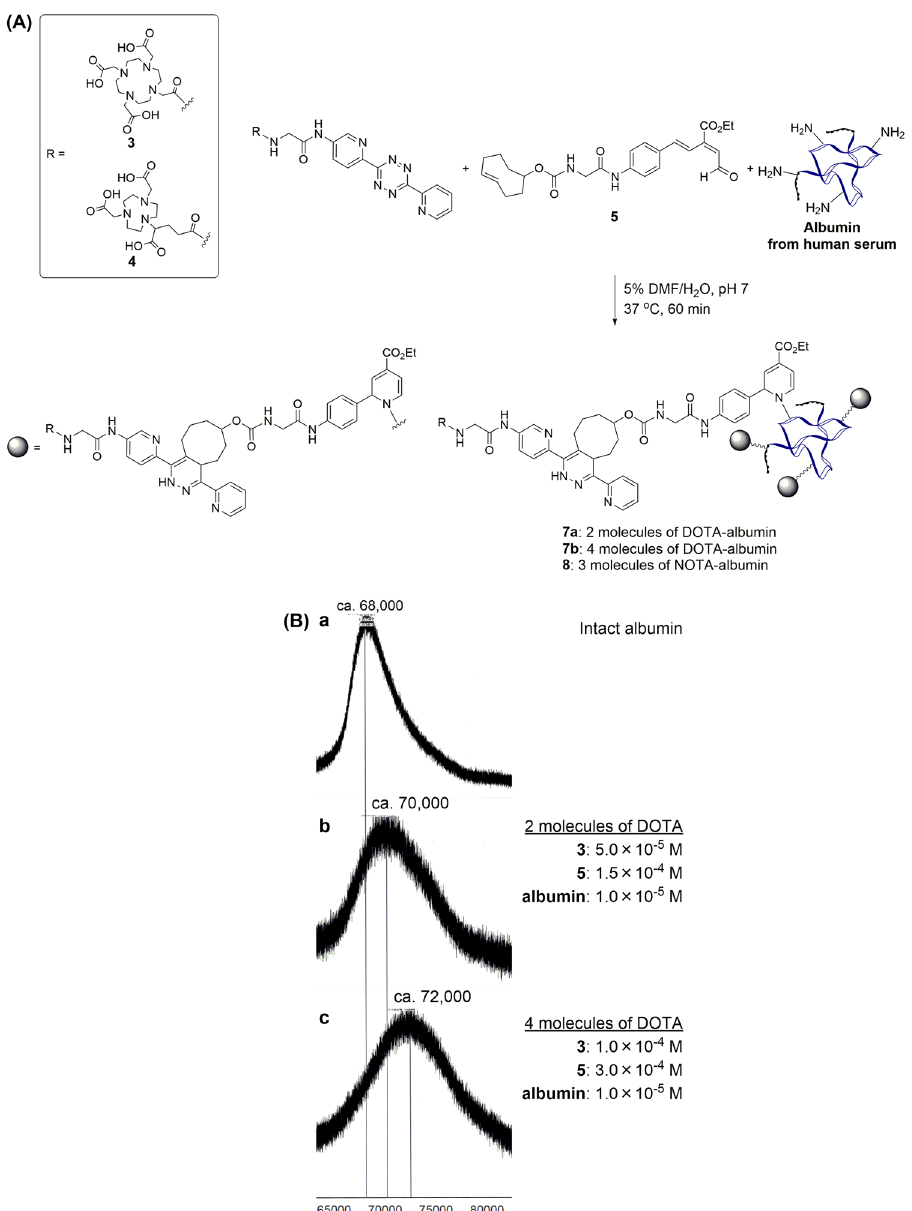
component click labeling. Spectra show: (a) Intact albumin. (b) DOTA-labeled albumin performed by using 3 and 5 at concentrations of 5.0 × 10 − 5 M and 1.5 × 10 − 4 M, and (c) 1.0 × 10 − 4 M and 3.0 × 10 − 4 M, for 60 min. DMF = N , N